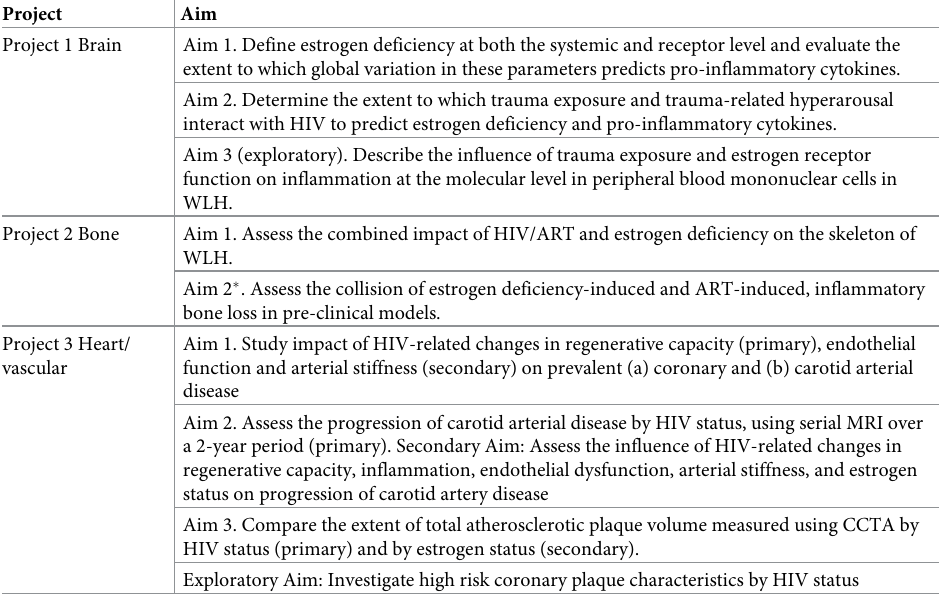
Table 1. Specific aims for each Brain, Bone, Heart (BBH) study